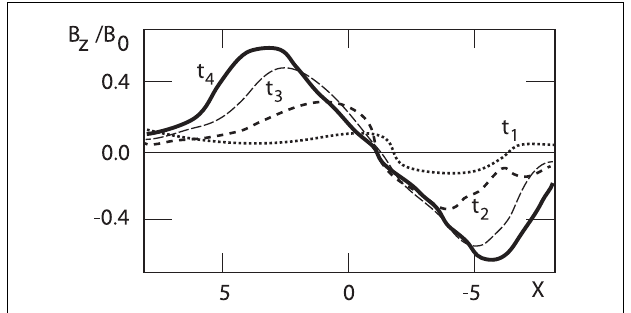
FIGURE 13 | Evolution of ‘dipolarization fronts’ in forced reconnection simulation with finite B z > 0 shown for four consecutive times. These fronts move to the left in the direction of Earth [schematized, simulation data after 175, courtesy American Geophysical Union].